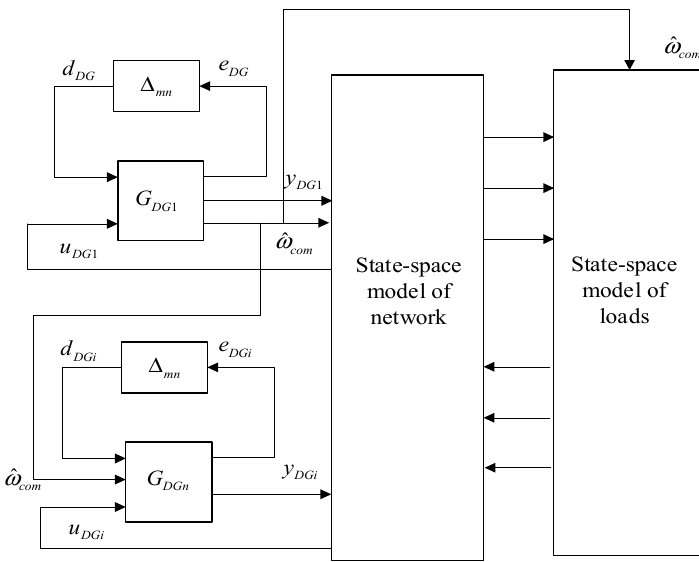
Figure 7. Block diagram of the complete state-space model of a MG.